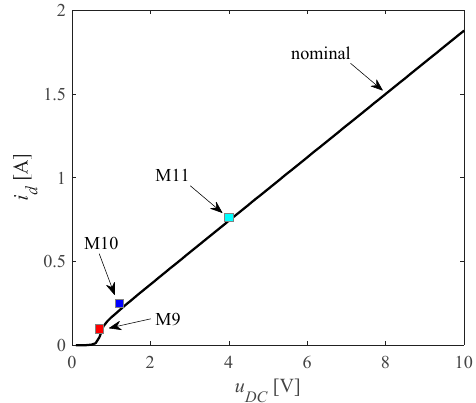
Figure 5. Current i d vs. voltage u DC .